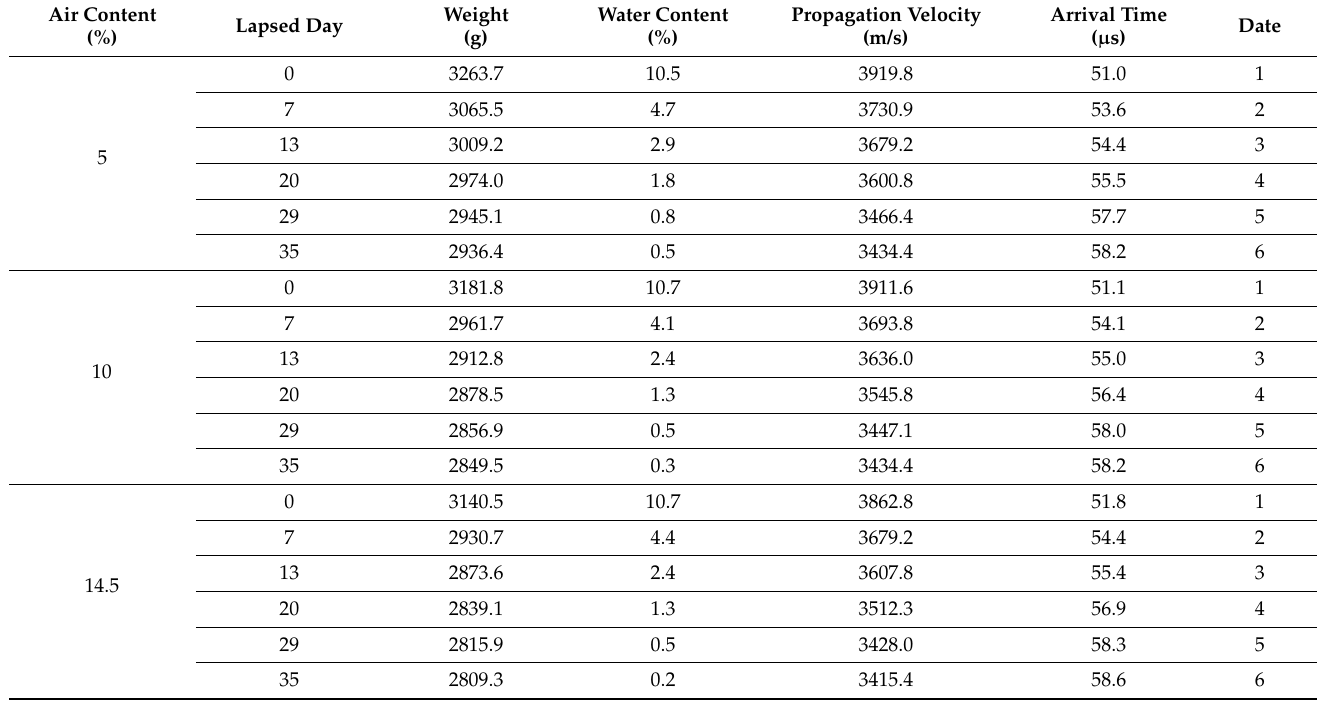
Table 1. Experimental